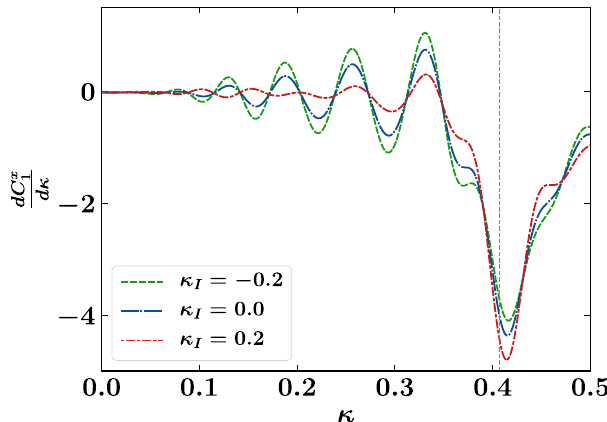
FIG. 5. Results for dC x 1 =d κ , as those in the inset in Fig. 3(a), obtained at a fixed time t ¼ 15 after the quench for different values of κ I ( ¼ − 0 . 2 , 0, 0.2) in the initial ground state. The vertical dashed line marks the critical κ c ≈ 0 . 41